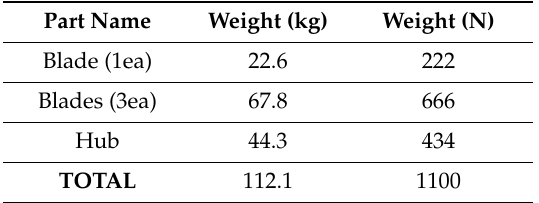
Table 5. The weight of blade(s) and hub specified on the contact surface.